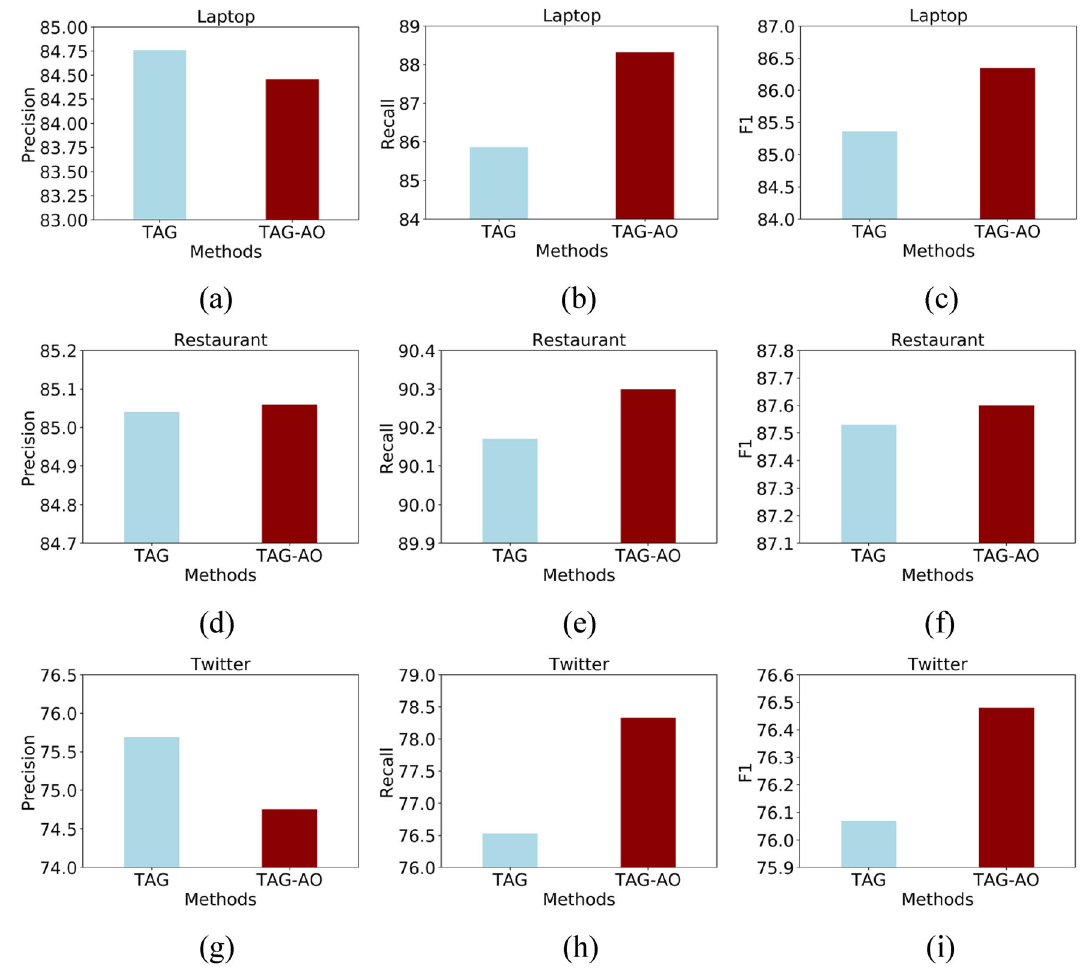
Fig. 10 The performance of models on the laptop, restaurant, and twitter datasets Table 6 The hyper-parameters and settings of the